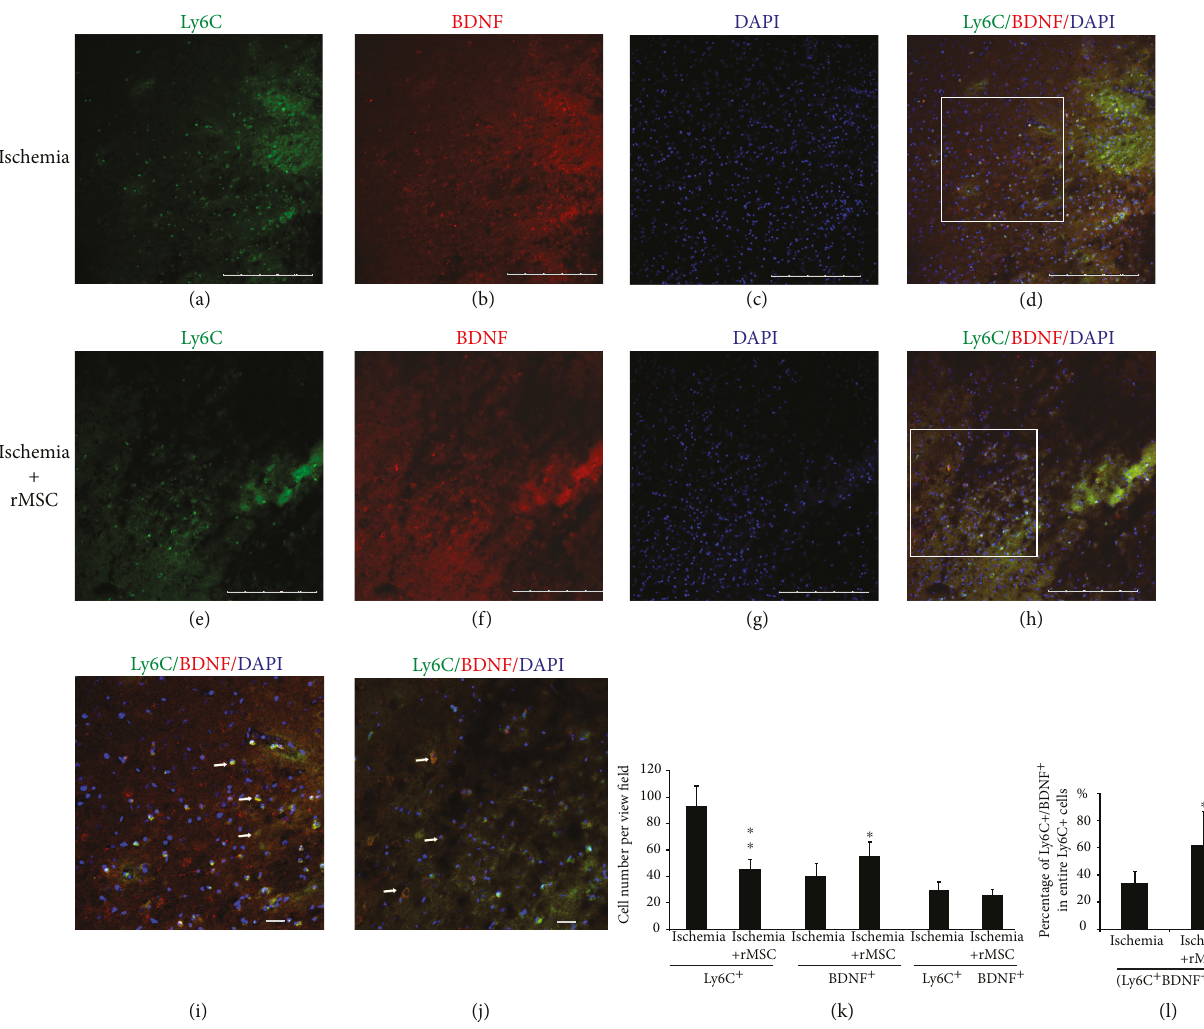
Figure 3: Ly6C + cells are one of the major contributors for BDNF production at day 2. (a – d) Distribution of Ly6C + and BDNF + cells in the infarct before MSC transplantation. (e – h) Distribution of Ly6C + and BDNF + cells in the infarct after MSC transplantation. (a, e) Ly6C staining. (b, f) BDNF. (c, g) DAPI nucleus staining. (d) Double-stained Ly6C + /BDNF + cells scattered in the infarct area after dMCAO. (h) Ly6C + /BDNF + cells 2 days after MSC transplantation. (i, j) Squares in (d) and (h). Ly6C + cell number was reduced in the infarct area 2 days after MSC transplantation, and the quantity and percentage of double-stained BDNF + Ly6C + cells were increased in these areas. (k) The cell counting results of Ly6C + , BDNF + , and Ly6C + /BDNF + cells before and after MSC transplantation. (l) The percentage of Ly6C + / BDNF + cells among Ly6C + cells was increased by MSC treatment. ( ∗ p < 0 05 and ∗∗ p < 0 01 , as compared with the ischemia vehicle group). Arrow: double-labeled cells. n = 5 ; scale bar: (a – h) 250 μ m and (i, j) 50 μ